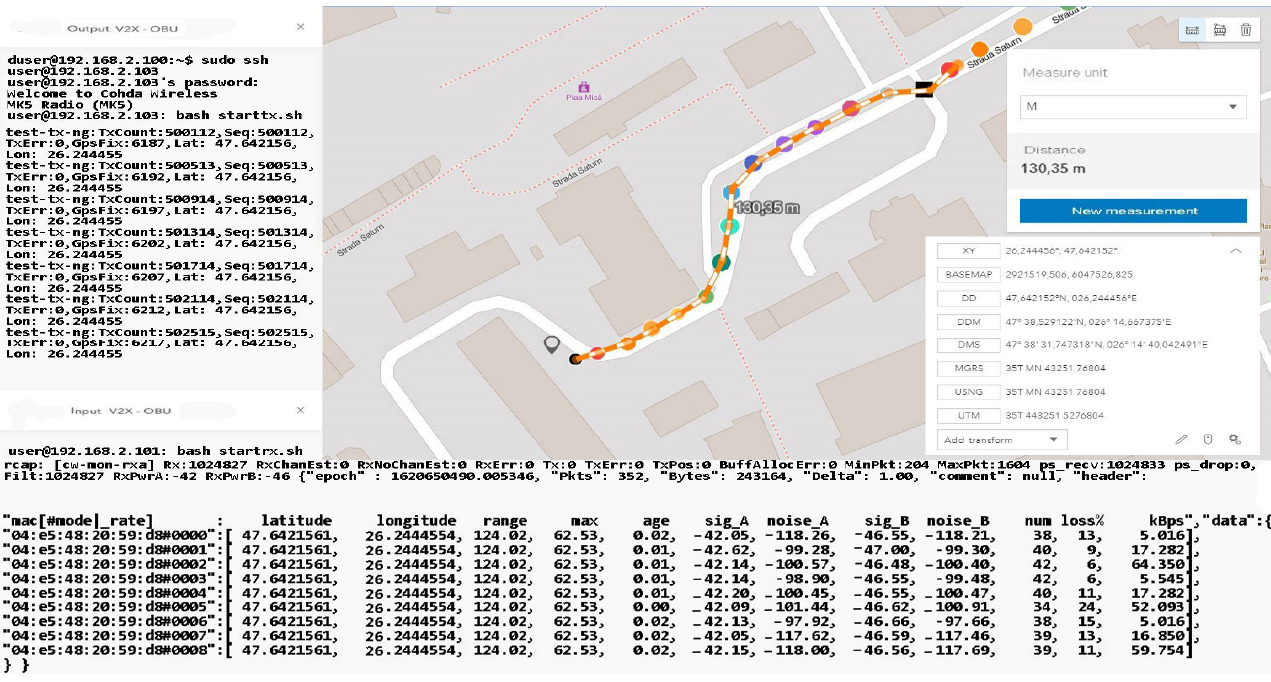
Figure 32. Simulated scenario at a distance of 130 m from the transmitter in a controlled environment.